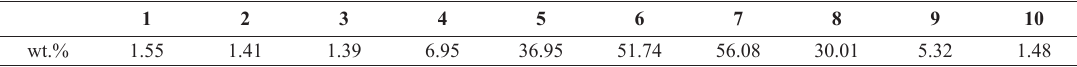
Table 2. EDS value of each test point in Figure